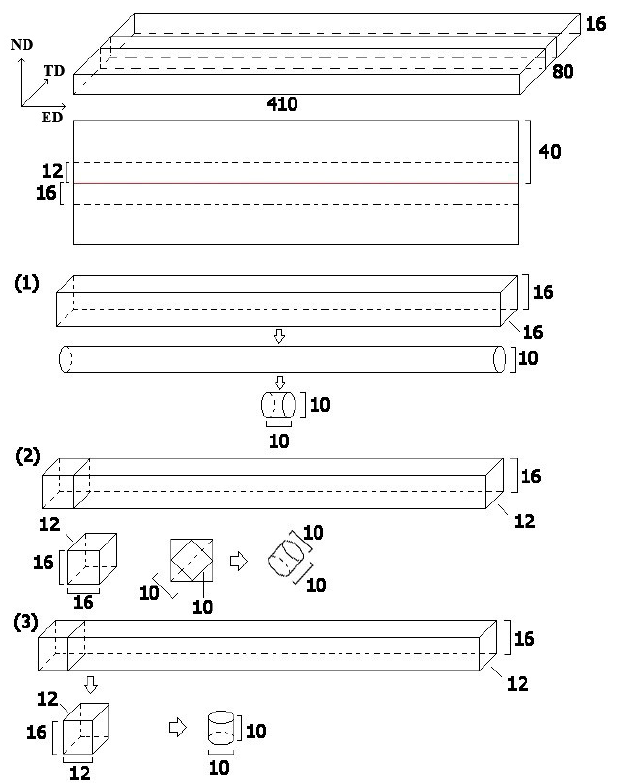
Figure 2. Schematic diagram of preparing Φ 10 mm × 10 mm cylindrical samples for high strain rate compression of (1) ED direction samples, (2) Horizontal 45 ◦ samples and (3) ND direction samples, compression of (1) ED direction samples, (2) Horizontal 45° samples and (3) ND direction samples, all units are in mm. all units are in